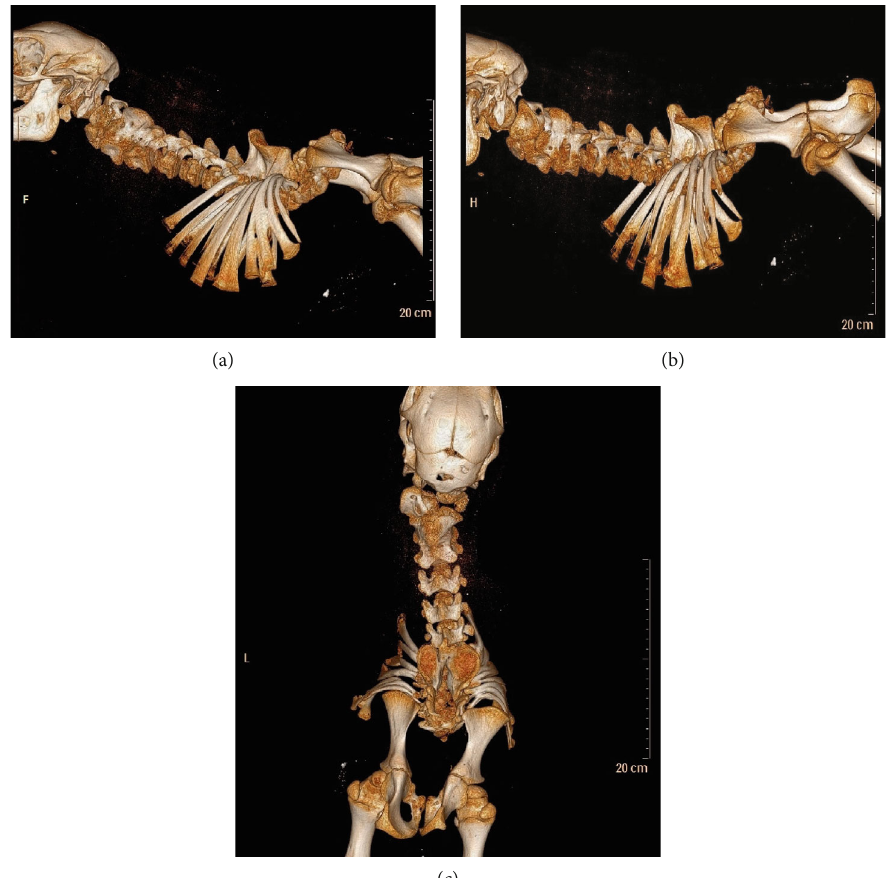
Figure 2: Right lateral (a), left lateral (b), and dorsoventral (c) computed tomography images of the calf revealing congenital partial lumbar and complete sacral and coccygeal vertebral aplasia consistent with perosomus